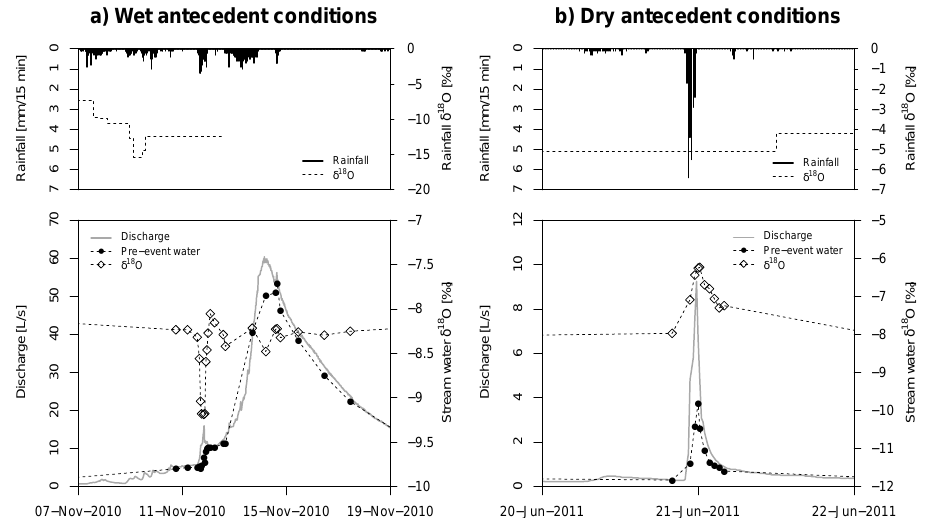
Figure 4. Two-component hydrograph separation for (a) the 7 November 2010 event (wet antecedent conditions) and (b) 20 June 2011 event (dry antecedent conditions) using δ 18 O isotopic